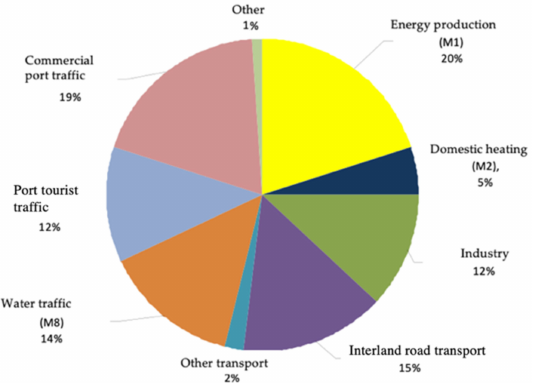
Figure 6. Pie chart of annual emission sources based on APICE